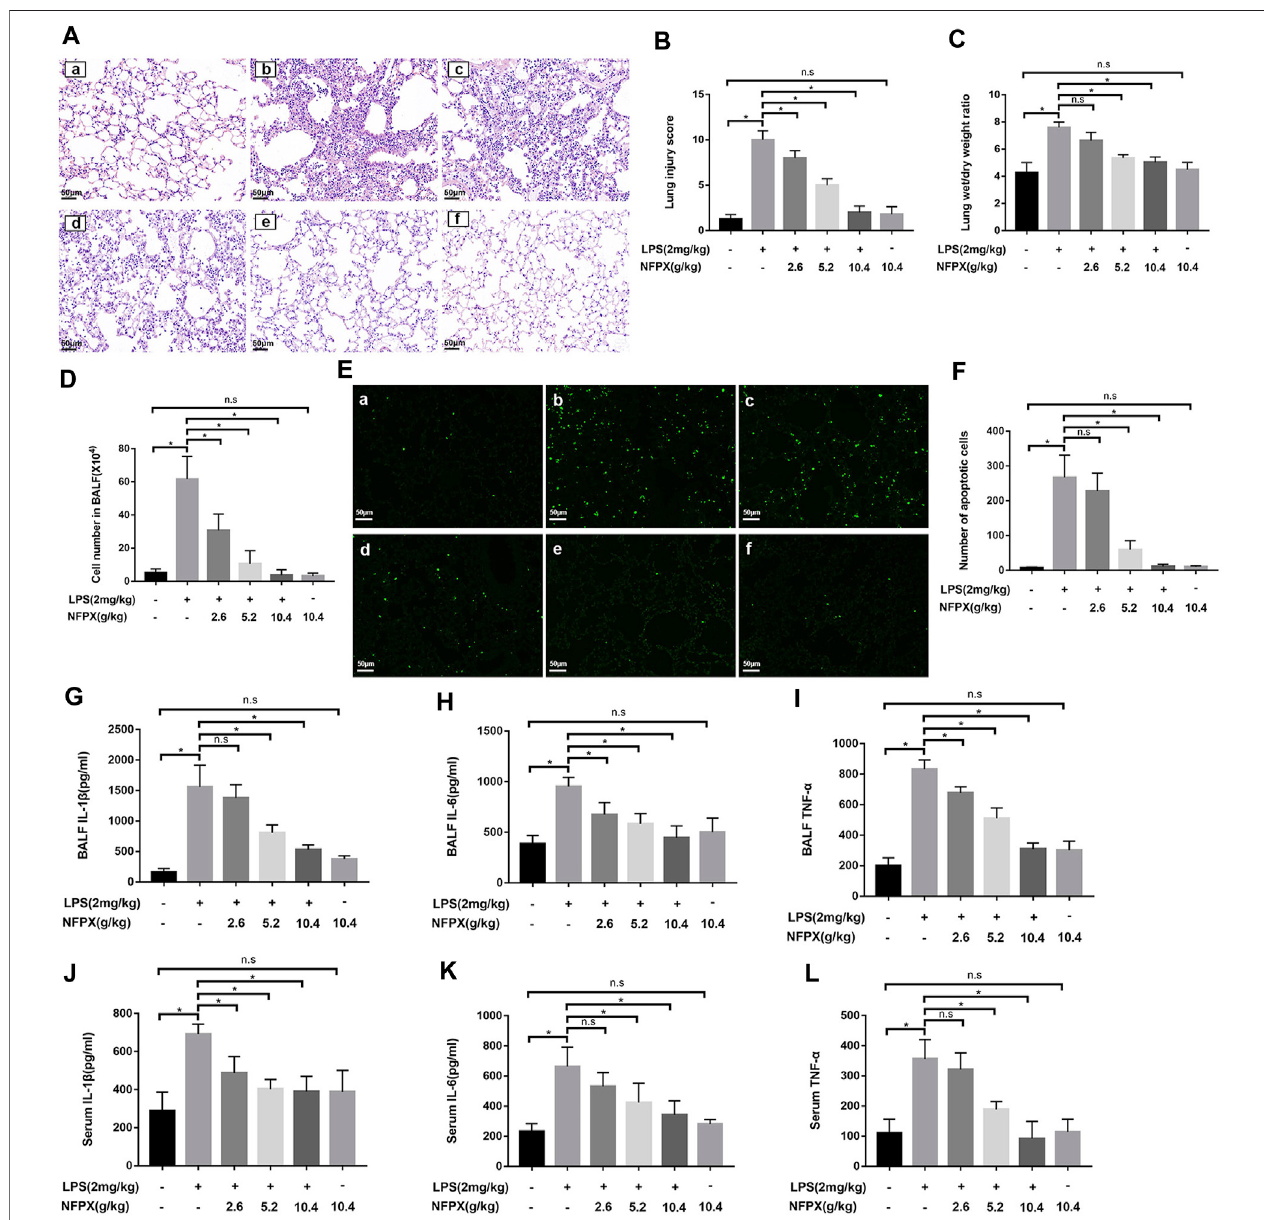
FIGURE3| NFPXmitigatesLPS-inducedARDSbyinhibitingcellapoptosisandin fl ammatoryreaction. (A , B) ThelunghistopathologyanalysiswasexaminedbyHE staining and scored by two independent pathologists. Scale bar, 50 μ m. (C) Lung wet/dry ratios were calculated by weighting the initial weight and the dry weight.